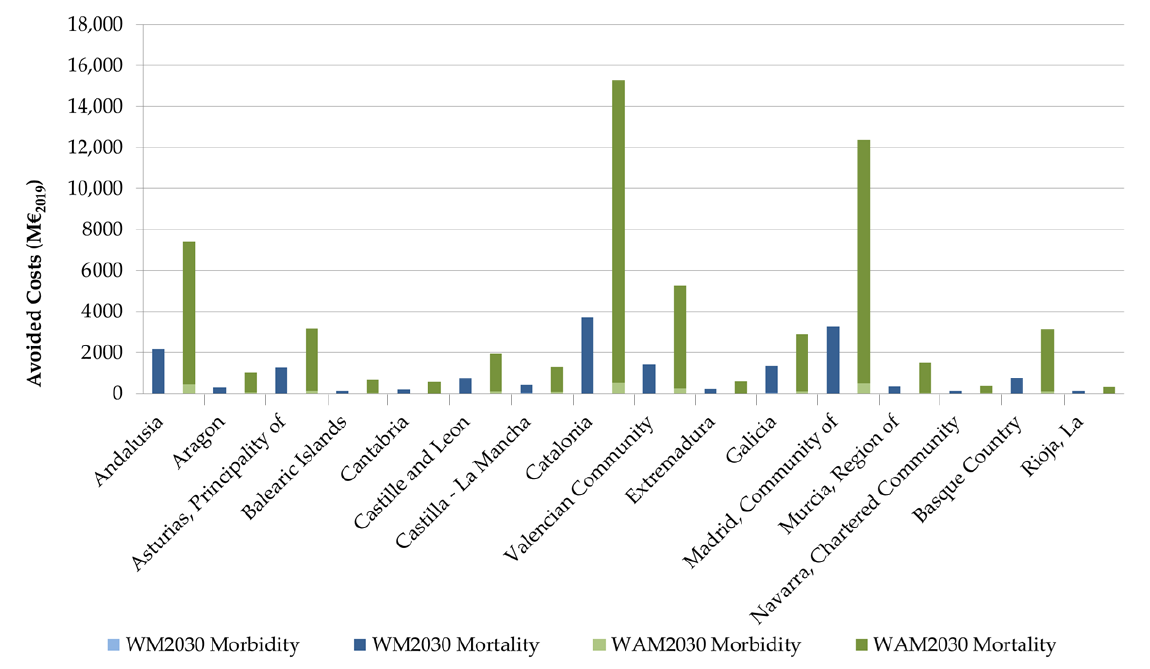
Figure 7. Distribution of the avoided costs per NUTS2.